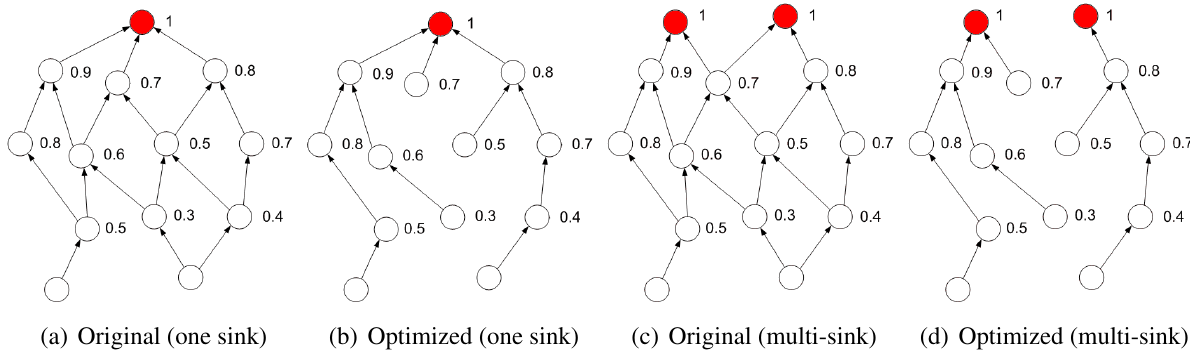
Figure 1. Directed acyclic graph based on heat